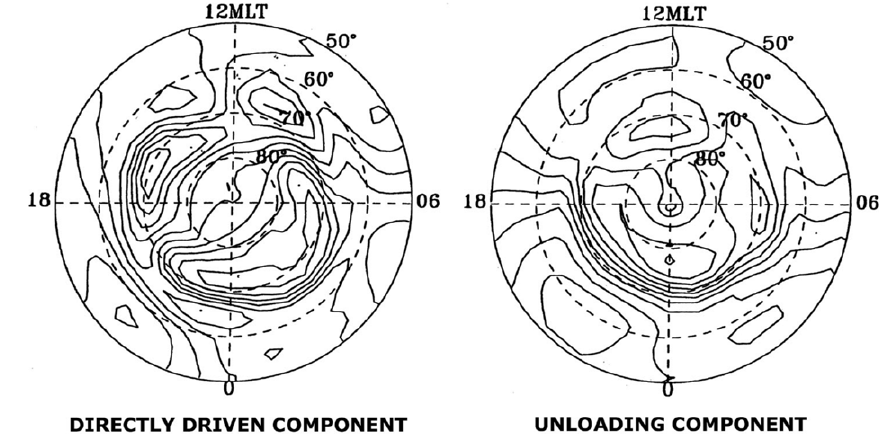
Fig. 2. Left: The solar wind-magnetosphere DD (the two-cell) current. Right: The substorm UL (the one-cell) current; (Sun et al., 1998).